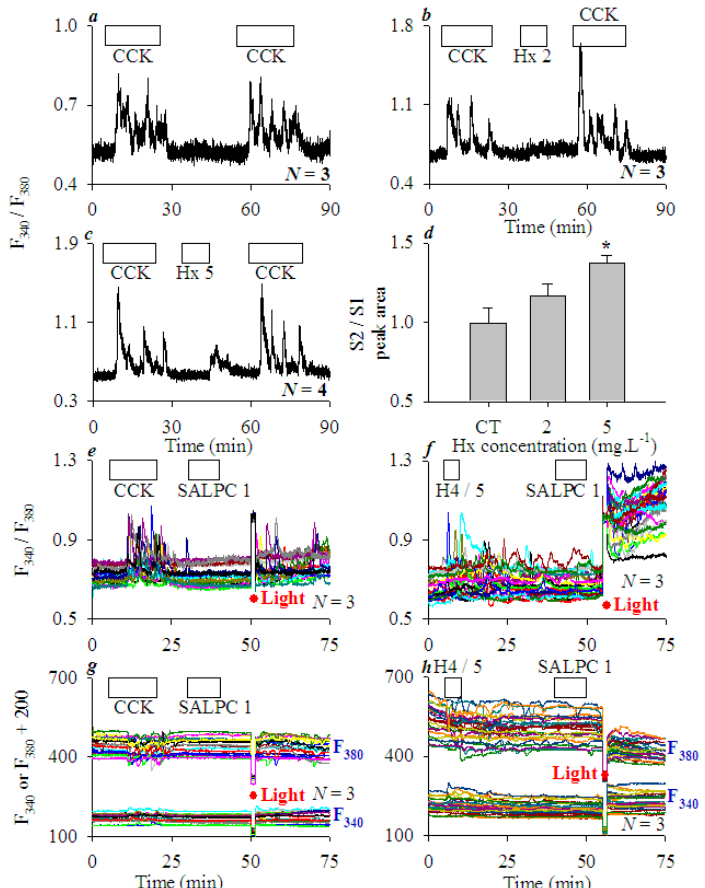
Figure A1. Histones sensitize CCK stimulation and SALPC photodynamic activation of CCK1R in AR4-2J cells. Fura-2-loaded AR4-2J cells were perifused, CCK (20 pM), mixed histones (Hx, 2, 5 mgL − 1 ), recombinant histone (H4, 5 mgL − 1 ), photosensitiser sulphonated aluminium phthalocyanine (SALPC, 1 µ M) were applied as indicated by the horizontal bars ( a – c , e – h ), light irradiation (36.7 mWatt · cm − 2 , 90 s) was indicated by red filled circles/interruptions in the tracings ( e – h ). ( a ) Tandem CCK stimulations (S1 and S2) in AR4-2J; S2 was enhanced by mixed histones (Hx) of 2 ( b ) and 5 ( c ) mgL − 1 , as confirmed by the analysis of S2/S1 (integrated areas under the calcium peaks above basal level, d ). Asterisk ( * ) in ( d ) indicates P < 0.05 in comparison with controls (CT, no Hx). ( e ) CCK was followed by SALPC and light irradiation. Note that SALPC alone in the dark had no effect, but subsequent light irradiation induced calcium oscillations. ( f ) H4 (5 mgL − 1 ) was followed by SALPC 1 µ M and light irradiation. Note the elevated basal calcium in ( f ) after light (photodynamic action). The corresponding F 340 and F 380 were plotted individually ( g , h ) as F 340 and F 380 + 200 for clarity ( g , h ). The tracings (F 340 /F 380 and F 340 , F 380 ) are each representative of N identical experiments ( N =